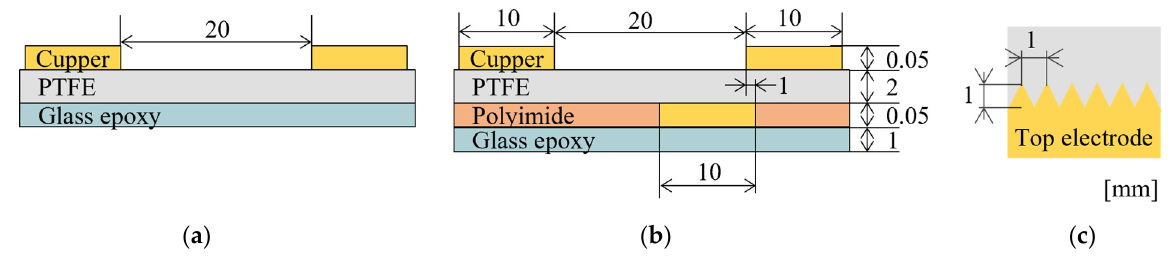
Figure 9. Schematics of the ( a ) CD-PA and ( b ) TED-PA: the left electrode is the DC electrode (applied the DC voltage), and the right electrode is the AC electrode (applied the AC voltage); ( c ) top view of the top electrode.